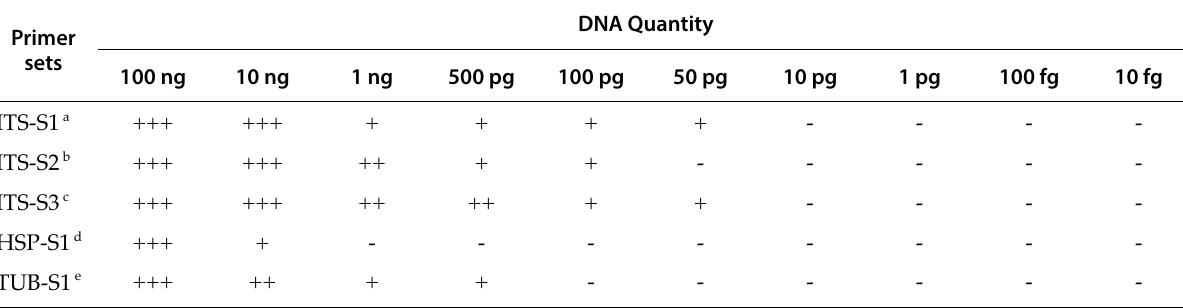
a ‒ e See Table 1.